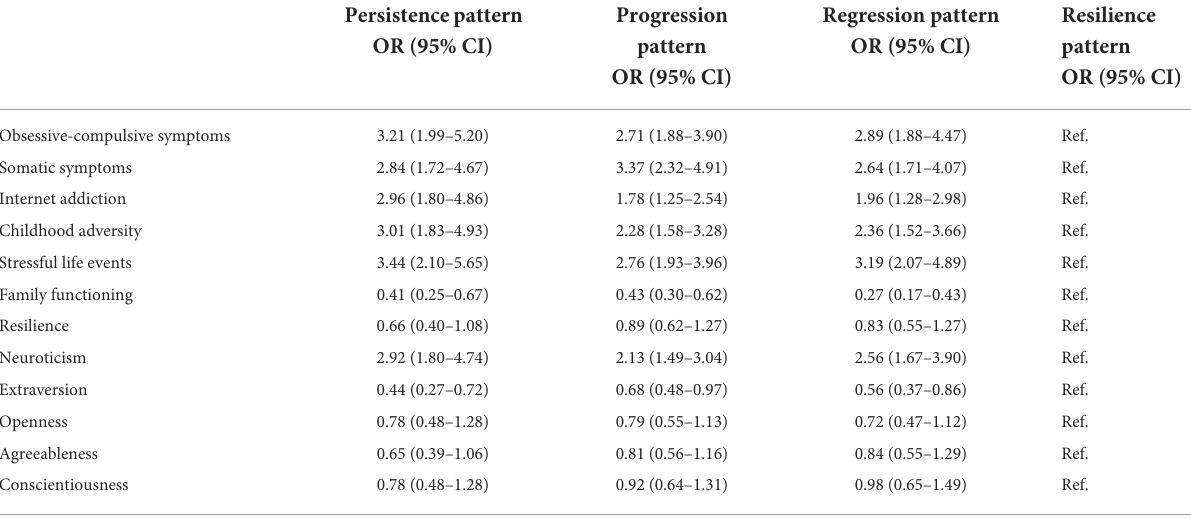
TABLE 3 Predictors associated with the overall mental burden changing patterns of the 863 undergraduate medical students a